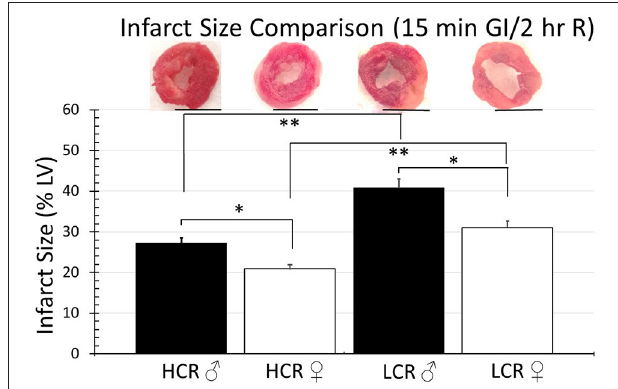
FIGURE 5 | Comparison of the average infarction size normalized to the whole heart between HCR male/female and LCR male/female rats after 15min ischemia and 2h reperfusion using an ex vivo buffer-perfused global ischemia (GI) model. Infarct sizes were smaller for all groups compared to 30min global ischemia ( Figure 3 ). Scale bars in images indicate 5mm. Significant differences were noted between sexes within each phenotype, and also between phenotypes for each sex, with LCRS having larger average infarctions compared to HCRs (* P < 0.05 for the comparison indicated between sexes within phenotype; ** P < 0.05 for the comparison indicated between phenotype within